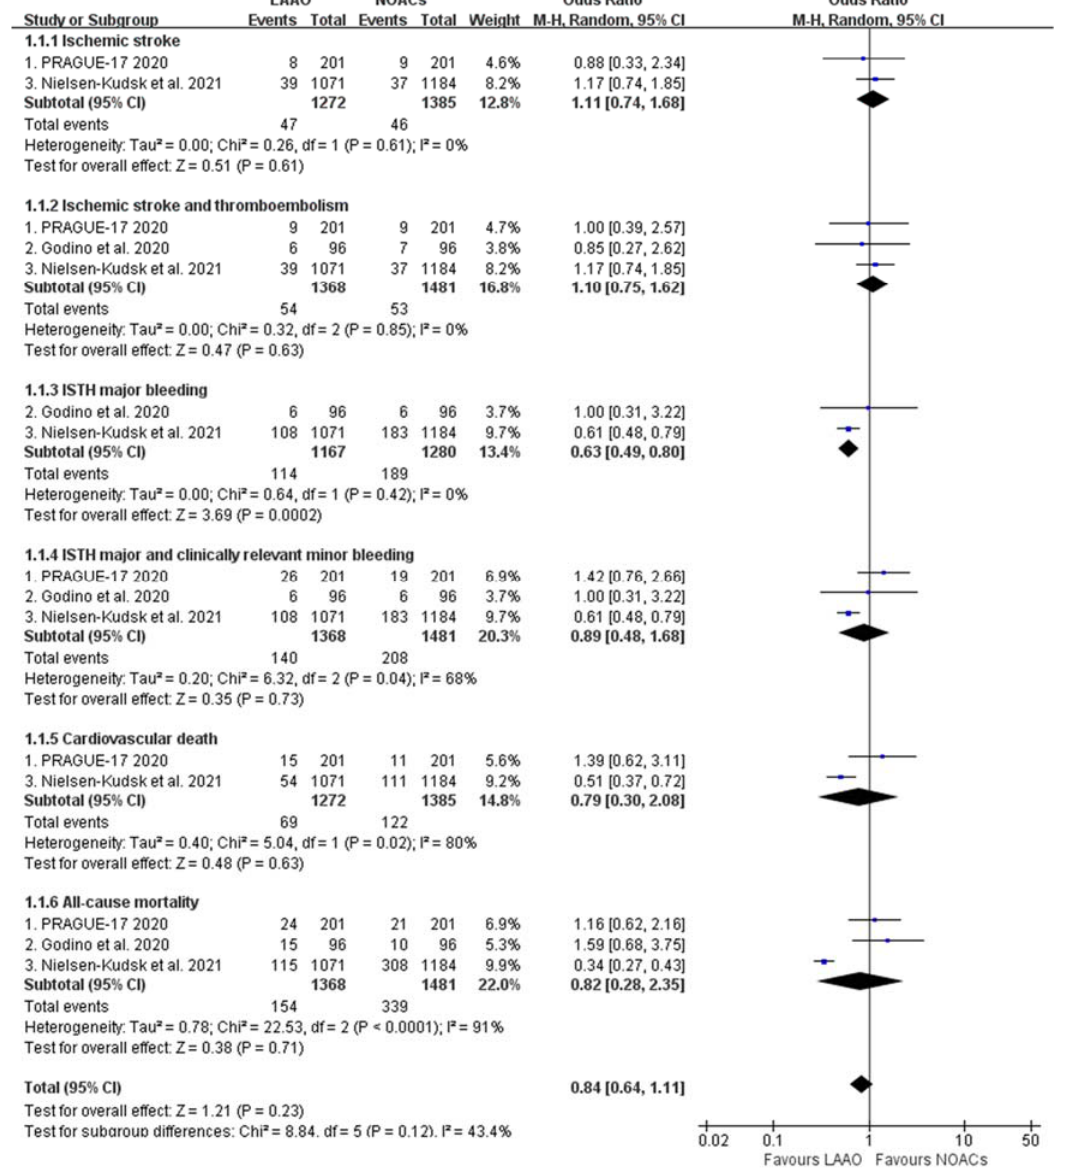
Table 3. LAAO implant success and LAAO procedure ‐ or device ‐ related serious complications.